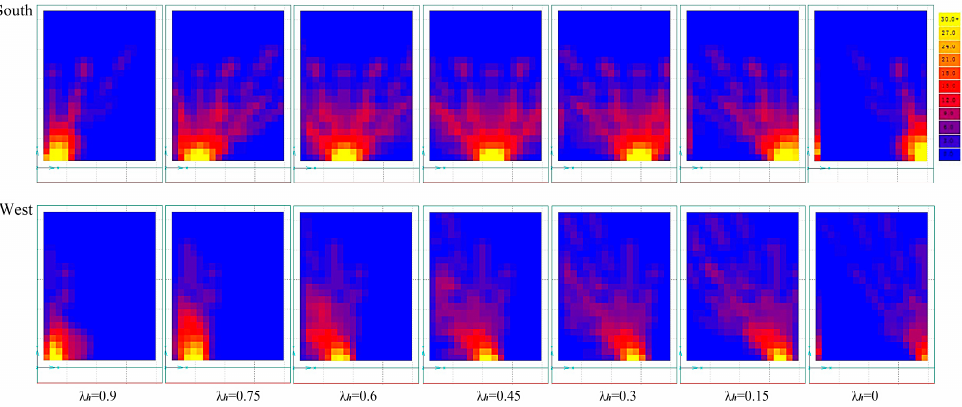
Figure 17. Distribution of over-day lit area in Group 3.